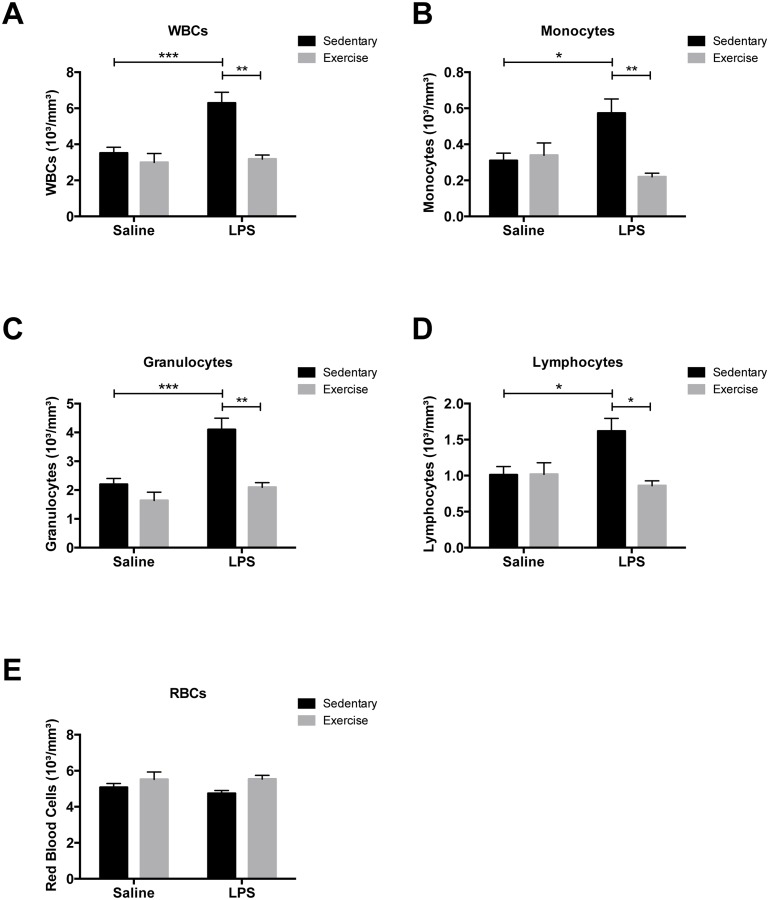
Exercise prevented LPS-induced increases in white blood cell counts.Exercise prevented LPS-induced increases in white blood cell (leukocyte) counts measured in blood samples collected on GD 17.5 (A). Exercise significantly abrogated LPS-induced increases in the number of circulating monocytes (B), granulocytes (C) and lymphocytes (D), but did not significantly alter the red blood cell count (E). Ex+LPS, n = 5; Ex+Saline, n = 5; Se+LPS, n = 11; Se+Saline, n = 10.